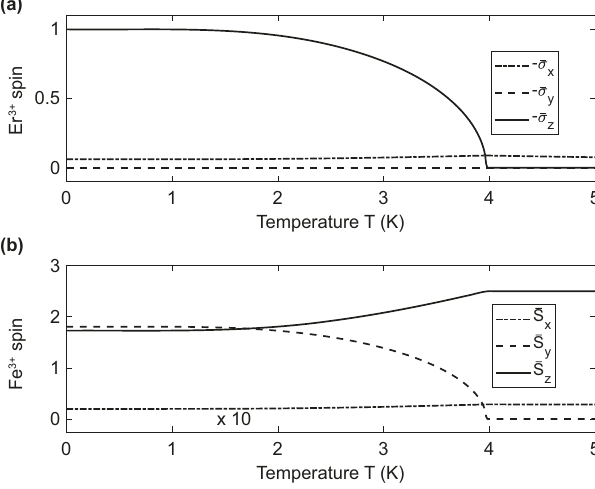
Fig. 2 Phase diagrams of spins in ErFeO 3 calculated using the mean- fi eld Fig. 3 Thermal equilibrium spin values. a Er 3 þ spin. b Fe 3 þ spin calculated method. An external DC magnetic fi eld was applied along the a a . b b . c c using the mean- fi eld method as functions of T in the case of zero external axes. The difference j (cid:2) σ A z (cid:3) (cid:2) σ B z j of the z components of the thermal- direct current (DC) magnetic fi eld. As shown in Fig. 3a, (cid:2) σ z ¼ (cid:2) σ A z ¼ (cid:3) (cid:2) σ B z equilibrium values of Er 3 þ spins is mapped in red. The bold solid curves spontaneously appears below T c ¼ 4 : 0K, i.e., the Er 3 þ spins are represent the phase boundaries. The external direct current (DC) magnetic antiferromagnetically ordered along the c axis. They show magnetization fi eld was varied from zero to positive or negative values at a fi xed along the a axis as (cid:2) σ x ¼ (cid:2) σ A = B x due to the Er 3 þ – Fe 3 þ exchange interaction temperature. As ErFeO shows weak magnetization along the a axis, the 3 with the weak Fe 3 þ magnetization along the a axis, whereas (cid:2) σ y ¼ (cid:2) σ A = B y ¼ 0. critical fi eld depends on whether the fi eld is parallel or antiparallel to the As shown in Fig. 3b, above T c , the Fe 3 þ spins are ordered magnetization in Fig. 2a. antiferromagnetically along the c axis as (cid:2) S z ¼ (cid:3) (cid:2) S A z ¼ (cid:2) S B z , whereas they are slightly canted toward the a axis as (cid:2) S x ¼ (cid:2) S A = B x , and (cid:2) S y ¼ (cid:2) S A y ¼ (cid:3) (cid:2) S B y = 0. Below T c , the Fe 3 þ spins rotate in the bc plane, and the rotation angle is